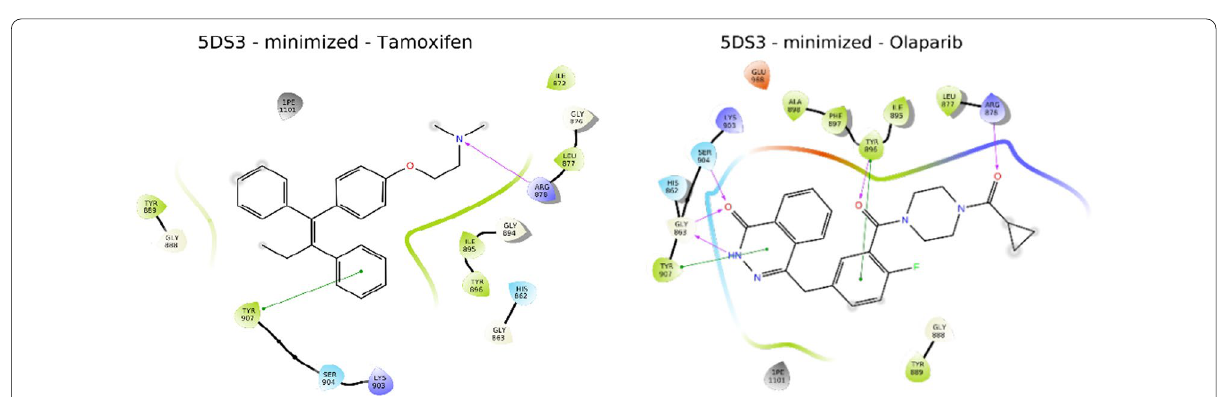
Fig. 5 Ligand interaction of Standard Tamoxifen and Olaparib with PARP-1